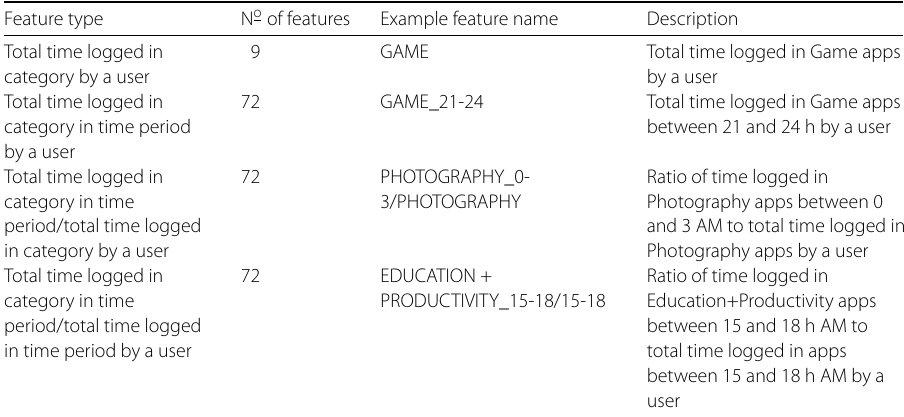
Table 6 Phone app category